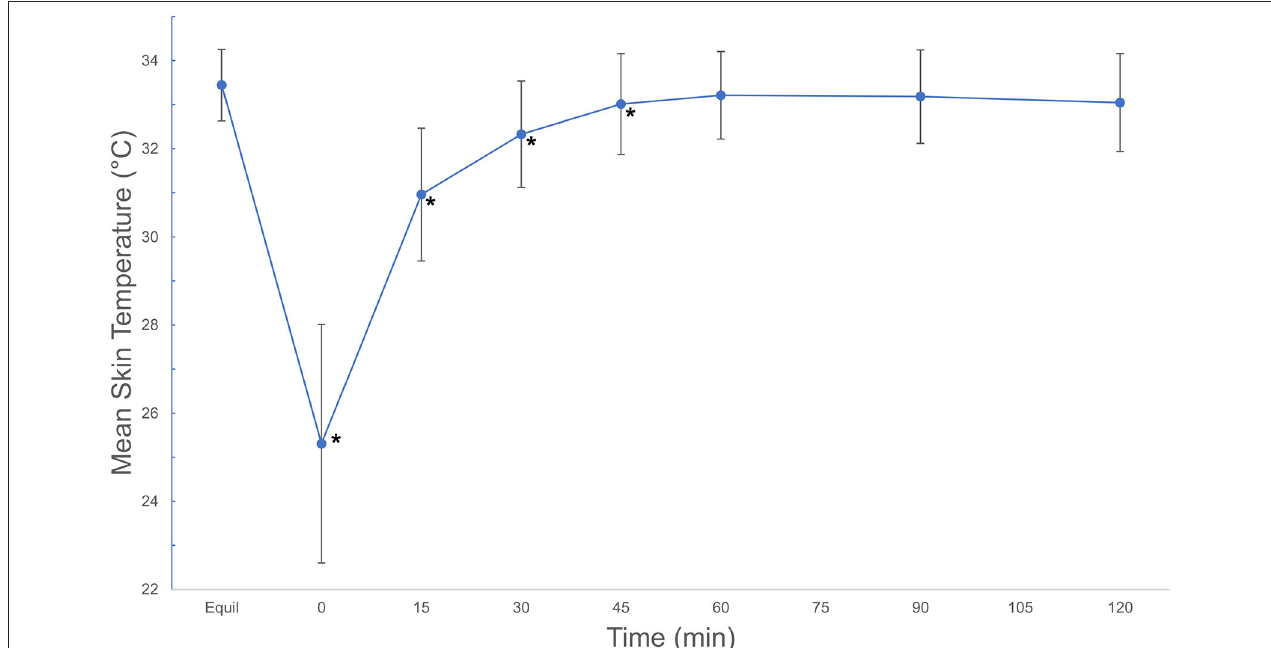
FIGURE 3 | Mean ± SD skin temperatures ( ◦ C) of all views combined, beginning after an equilibration period, then continuing after a 20-min cryotherapy at 0min and following rewarming for 120min. Asterisks indicate significant difference from equilibrium ( p < 0.001). © 2021 by Sang Chul Woo is licensed under CC BY 4.0. To view a copy of this license, visit